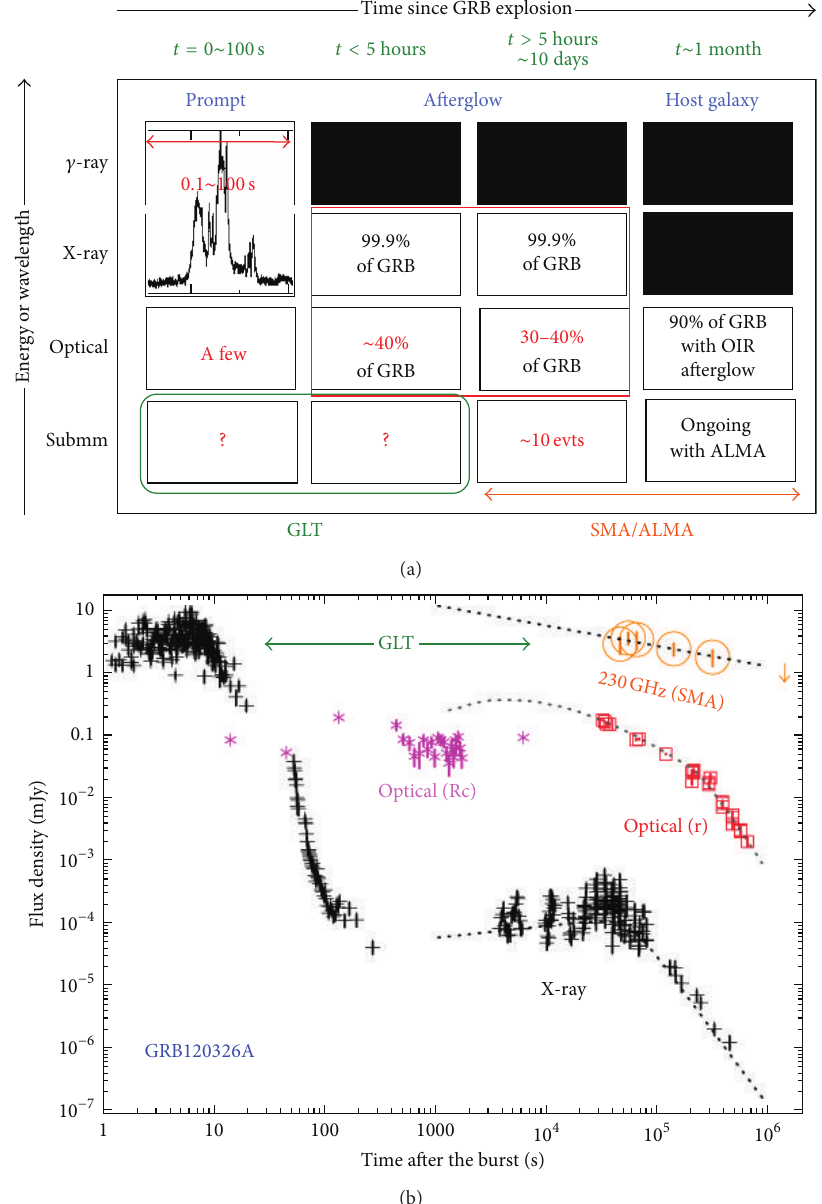
Figure 1: (a) Schematic summary of the GRB observational achievements along with time from the bursts in individual wavelength (from 𝛾 -ray to submm). (b) One of actual light curves in X-ray, optical, and submm with the earliest submm